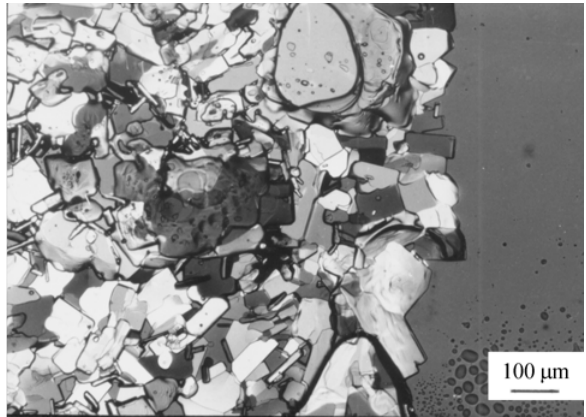
Figure 2. Calibration of temperature gradient through the melting of phenacitin crystals, with the lower temperature at the left and the higher temperature at the right hand side of the photograph. Melting front is at 134.5 °C. Original magnification